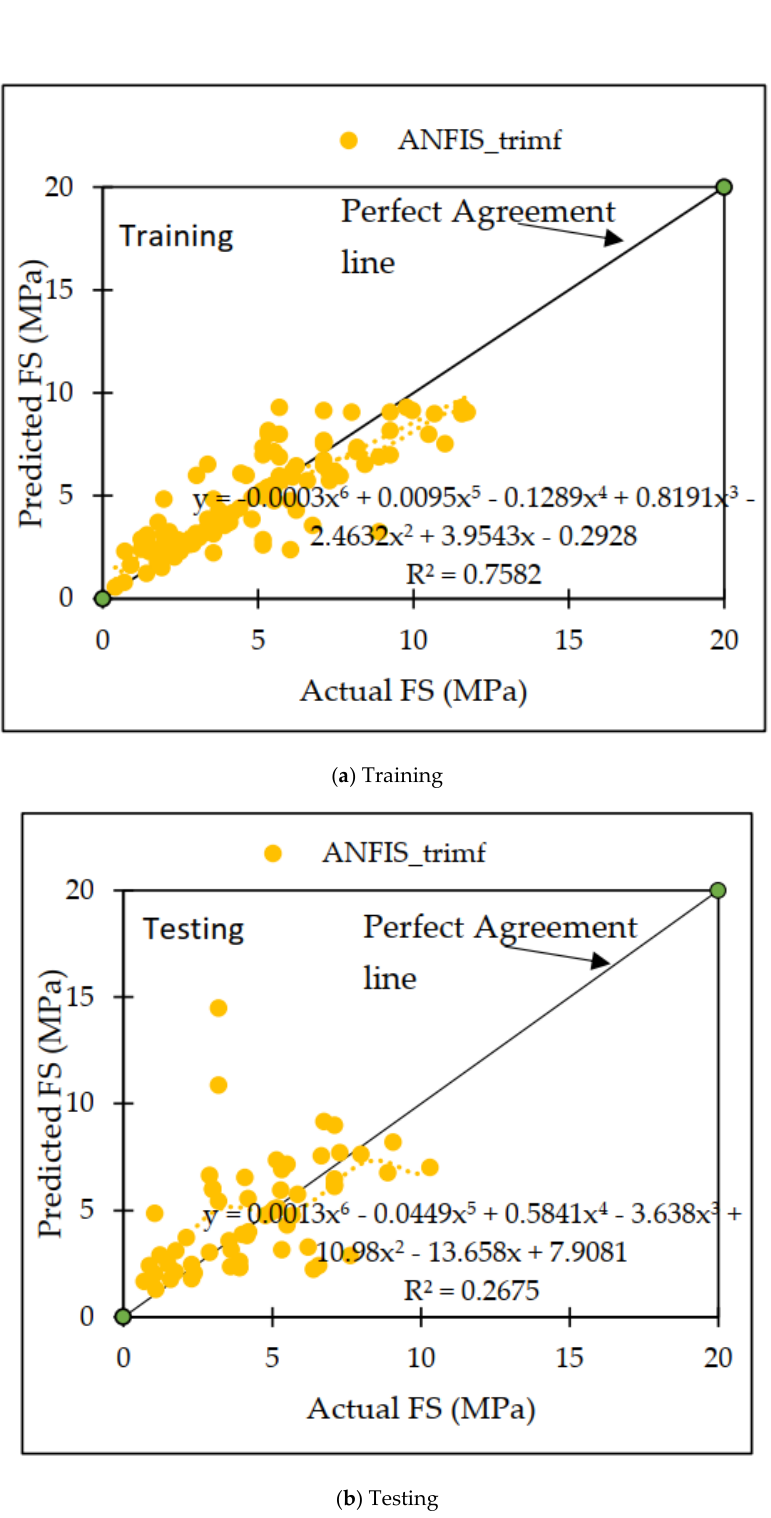
Figure 6. The scatter graph shows observed and expected ANFIS FS